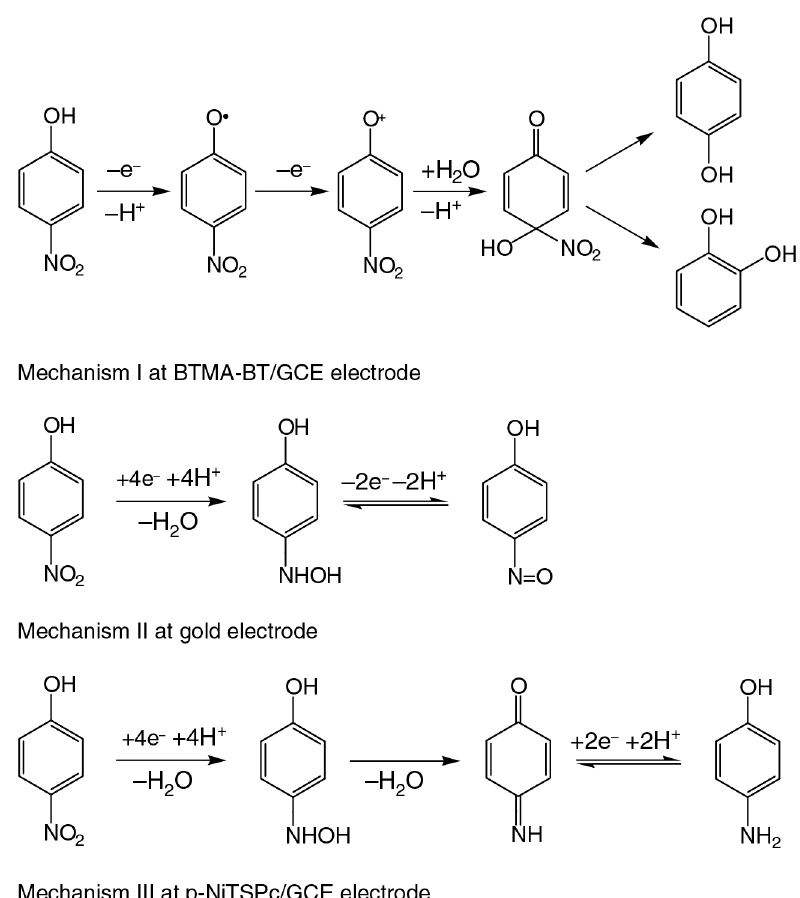
Figure 2: Possible p -NP electrochemical oxidation pathways: mechanism I (Zunic et al. 2014; © Copyright Elsevier BV), mechanism II (Liu et al. 2009; © Copyright Elsevier BV), and mechanism III (). Reproduced with permission.